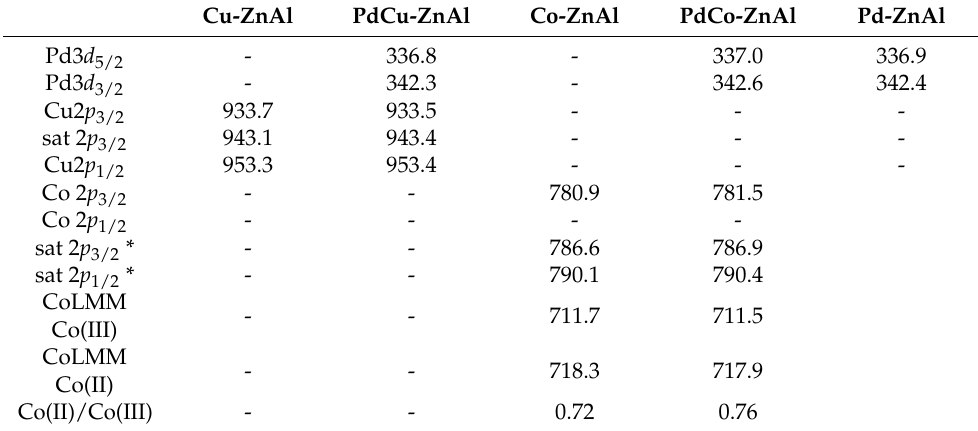
Table 3. XPS Binding energies (B.E.) of palladium, copper and cobalt species, K.E. of cobalt Auger transitions and Co(II)/Co(III) atomic